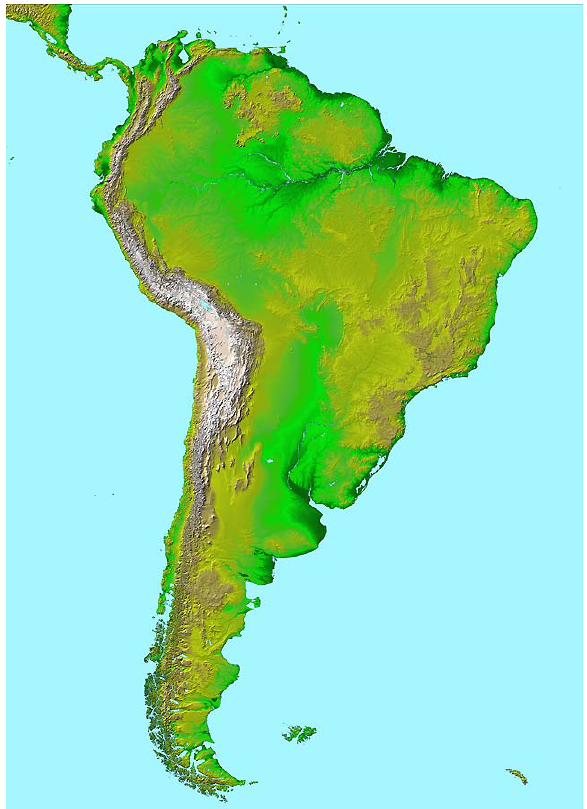
Fig. 1. The prominent mountainous belt making up the Andean chain ( Cordillera de Los Andes ) stretches approximately 8000km north to south from Venezuela to Patagonian Chile along the west- ern margin of South American continent. The Andes – the “back- bone” of South America – are clearly seen in this Radar Shuttle To- pography image. (SRTM NASA/JPL, http://photojournal.jpl.nasa. gov/tiff/PIAO3388.tif).